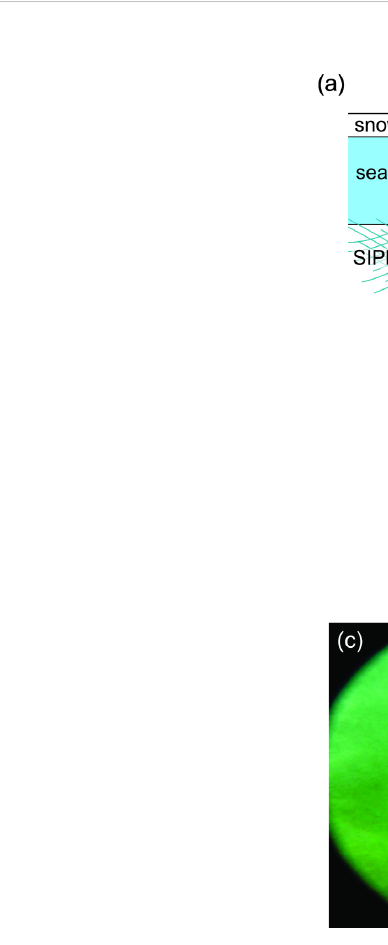
FIGURE 2 Camp setup showing (A) mooring and (B) hydro container (HC) with echo sounder (ES) and turbulence pro fi ler (TP). (C) Upwards looking view from camera mounted on CTD frame showing the hydrohole (HH). The sensors other than echo sounder are not discussed here but include a supercoolometer and a Nobska